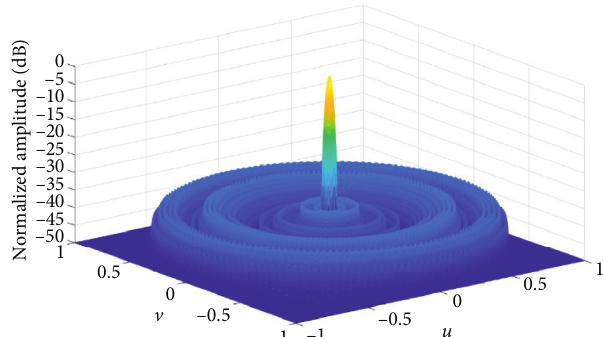
Figure 4: 3D pattern of the UECRA when N � 2256.